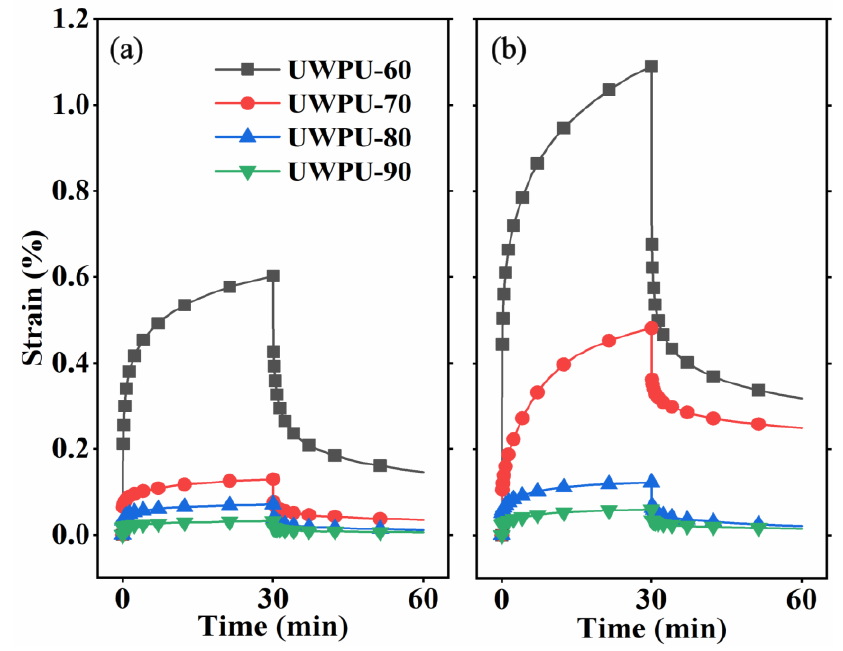
Figure 7. Creep curves of UWPU composites at ( a ) 30 °C and ( b ) 60 °C.